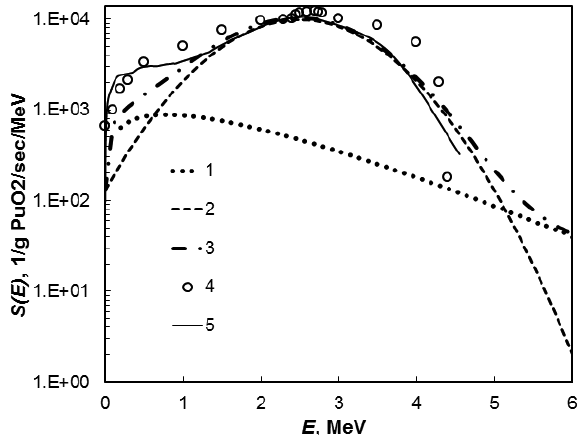
neutrons: 1 – sponta- Figure 1. Spectral distribution of PuO 2 neous fission; 2 – desired, (α ,n)-reaction ( a = 0.85, b = 2.50); 3 – combined desired, {c ( E ) + c ( E )}; 4 – combined (Taherza- sf a n deh and Gingo Peter 1972) ; 5 – combined (approximation of the EXFOR and ENDSF library